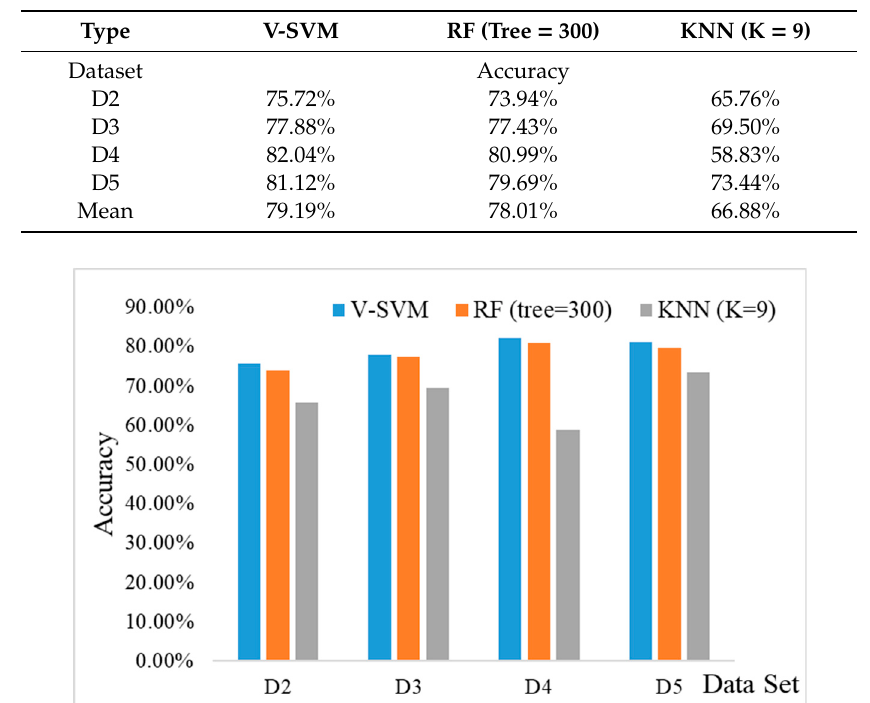
Table 6. Comparison of prediction performance of support vector machine (SVM), RF, and KNN.